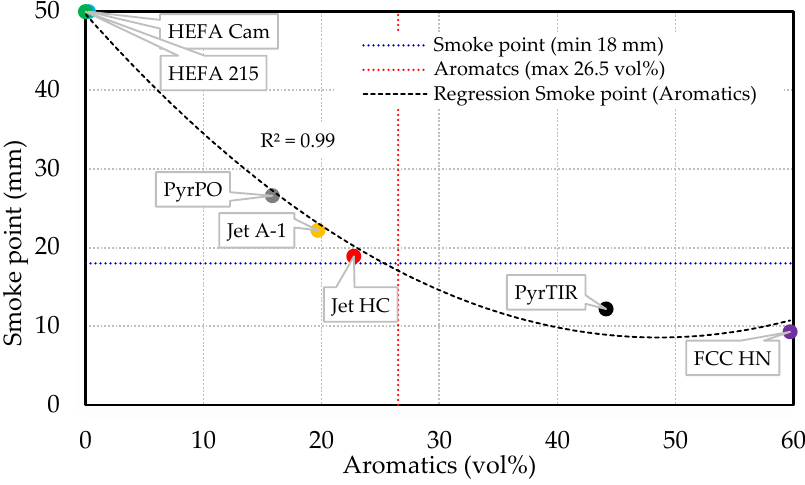
Figure 9. Smoke point relation to the aromatics content for the samples studied.